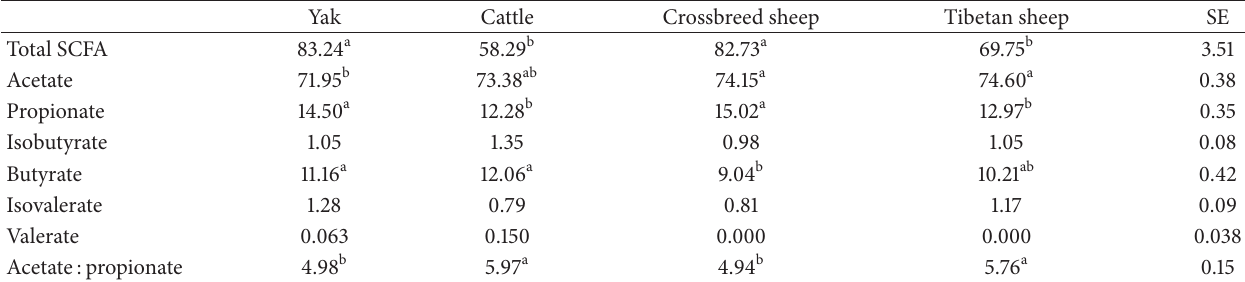
Table 2: Rumen total SCFA concentration (mM) and proportions (mol100 −1 mol) in ruminant species.